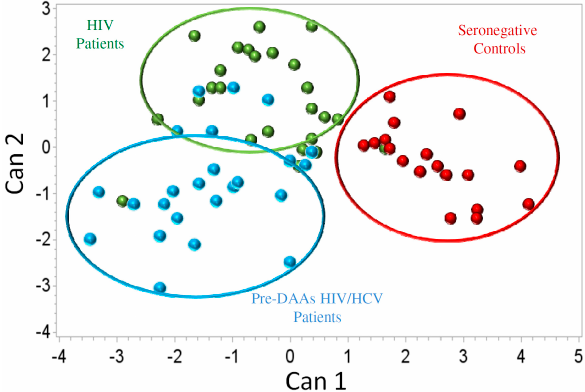
Figure 2. Canonical discriminant analysis comparing the phenotypic profile of T cells between HIV-monoinfected patients (green dots), pre-DAAs HIV/HCV coinfected patients (blue dots) and seronegative controls (red dots).